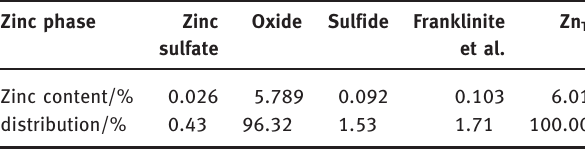
Table 2: Zinc phase of low-grade oxide zinc ores (mass fraction,